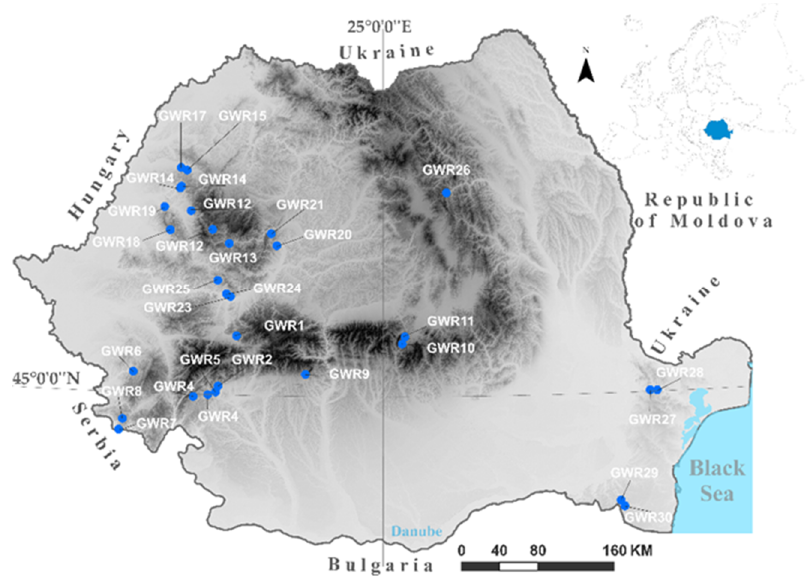
Figure 1. The sampled karstic springs in Romania (blue dots) and the position of the country in Europe (upper right).